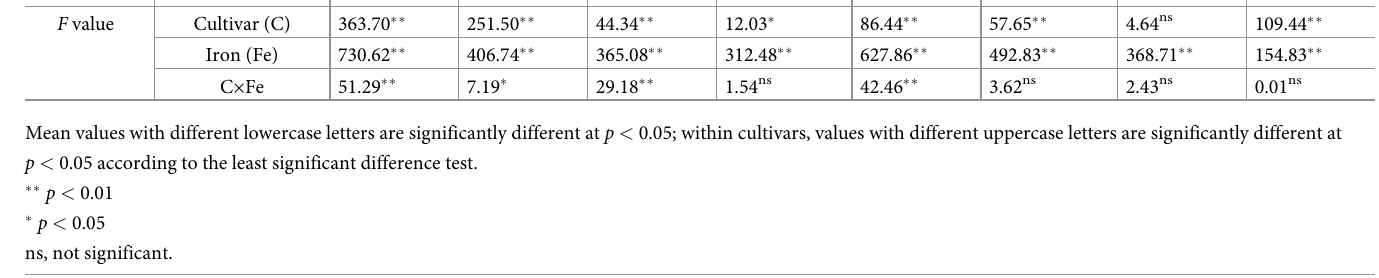
decreased by 23.92% and 71.48%, the root dry weight decreased by 51.74% and 68.63%, and the total dry weight decreased by 33.48% and 70.52%, respectively, whereas the root to shoot ratio decreased by 36.87% and increased by 9.97%, respectively. At 28 d after treatment, the shoot dry weight of ZH 2 and CD 418 decreased by 54.04% and 89.00%, respectively, the root dry weight decreased by 55.17% and 81.42%, and the total dry weight decreased by 54.31% and 86.99%, whereas the root to shoot ratio increased by 0.12% and 69.41%, respectively. Under low Fe stress, the decreases in shoot, root, and total dry weight, and the increases in the Fe-effi- cient cultivar ZH 2 were significantly lower than those of the Fe-inefficient cultivar CD 418. In addition, the differences in dry weight between the two cultivars increased with longer stress times.